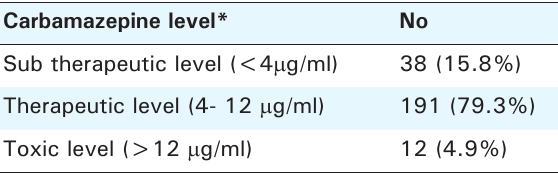
Table 3. Serum Carbamazepine level (n=241)